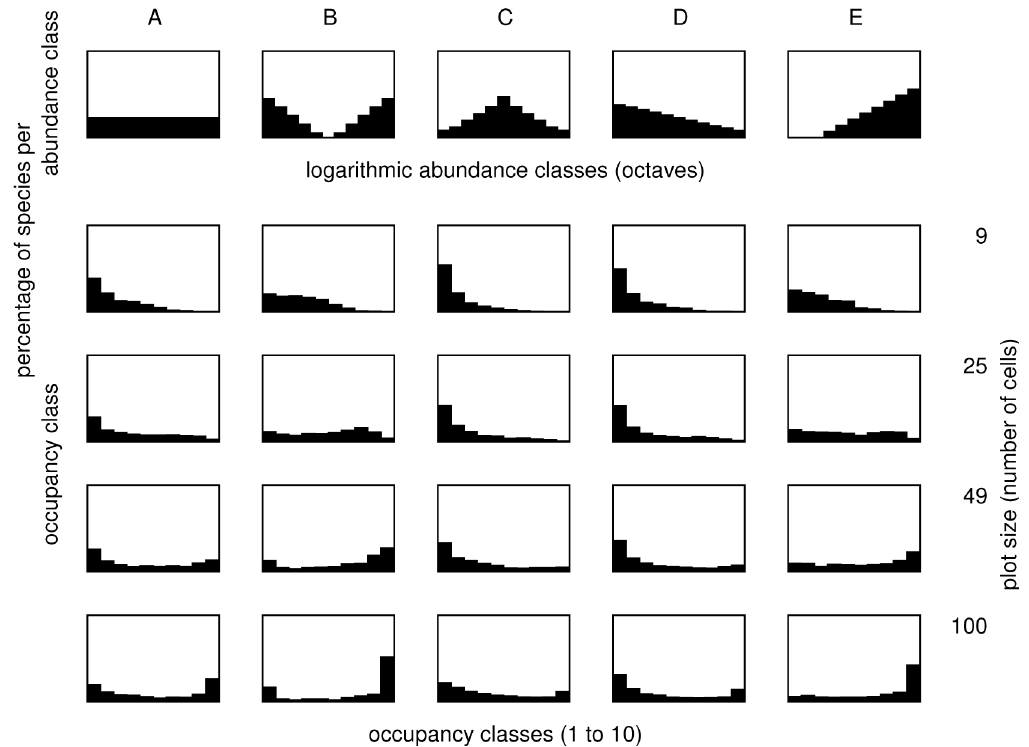
Figure 5. Abundance distributions of the artificial assemblages A to E (top line) and the resulting average occupancy distributions in different plot sizes (number of cells per plot). Mean percentage of species per abundance and occupancy classes are indicated since the number of species is highly different among the five artificial assemblages (for details see